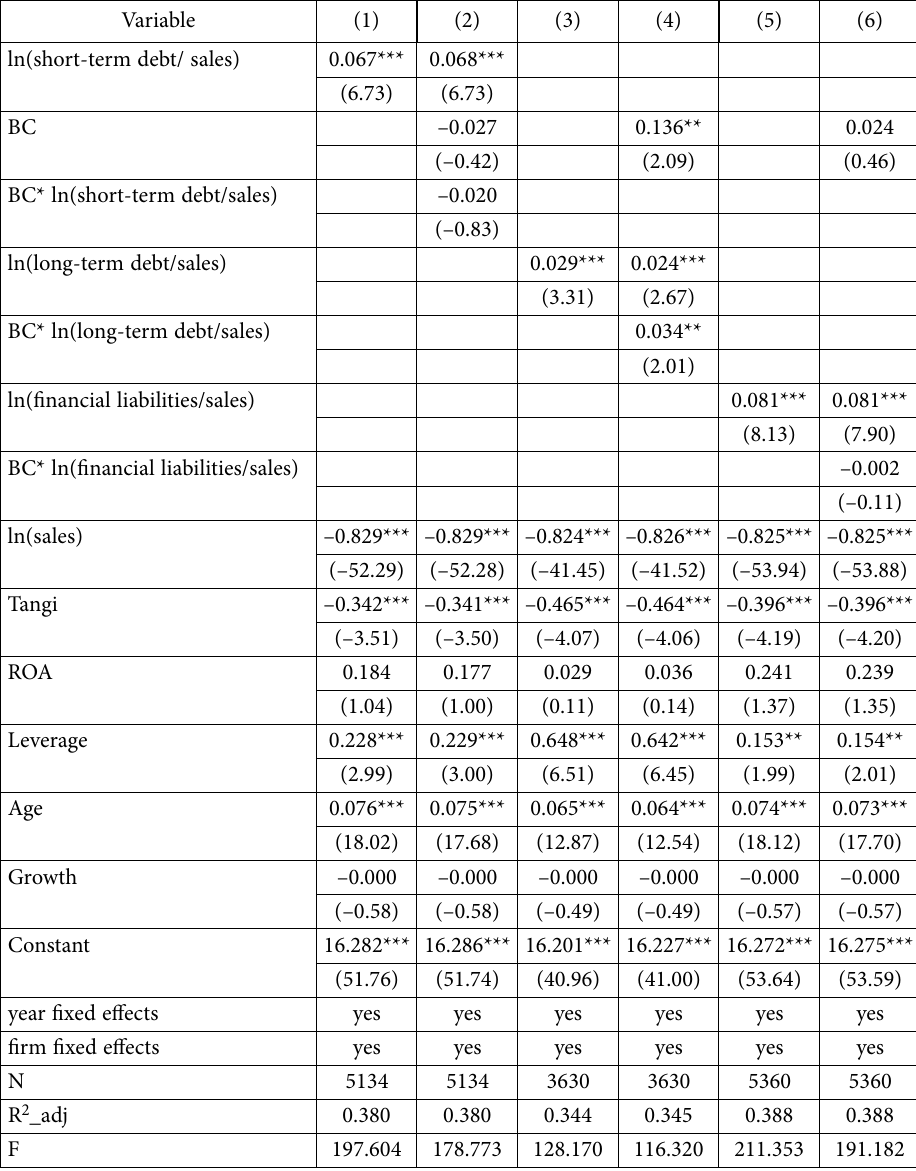
Table 6. Robustness test